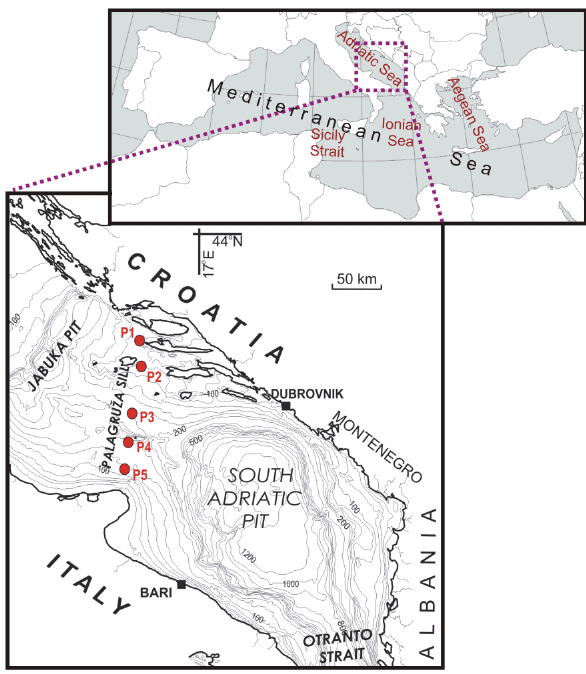
Fig. 1. The investigated area, with locations of stations (P1 to P5) along the Palagruža Sill transect.